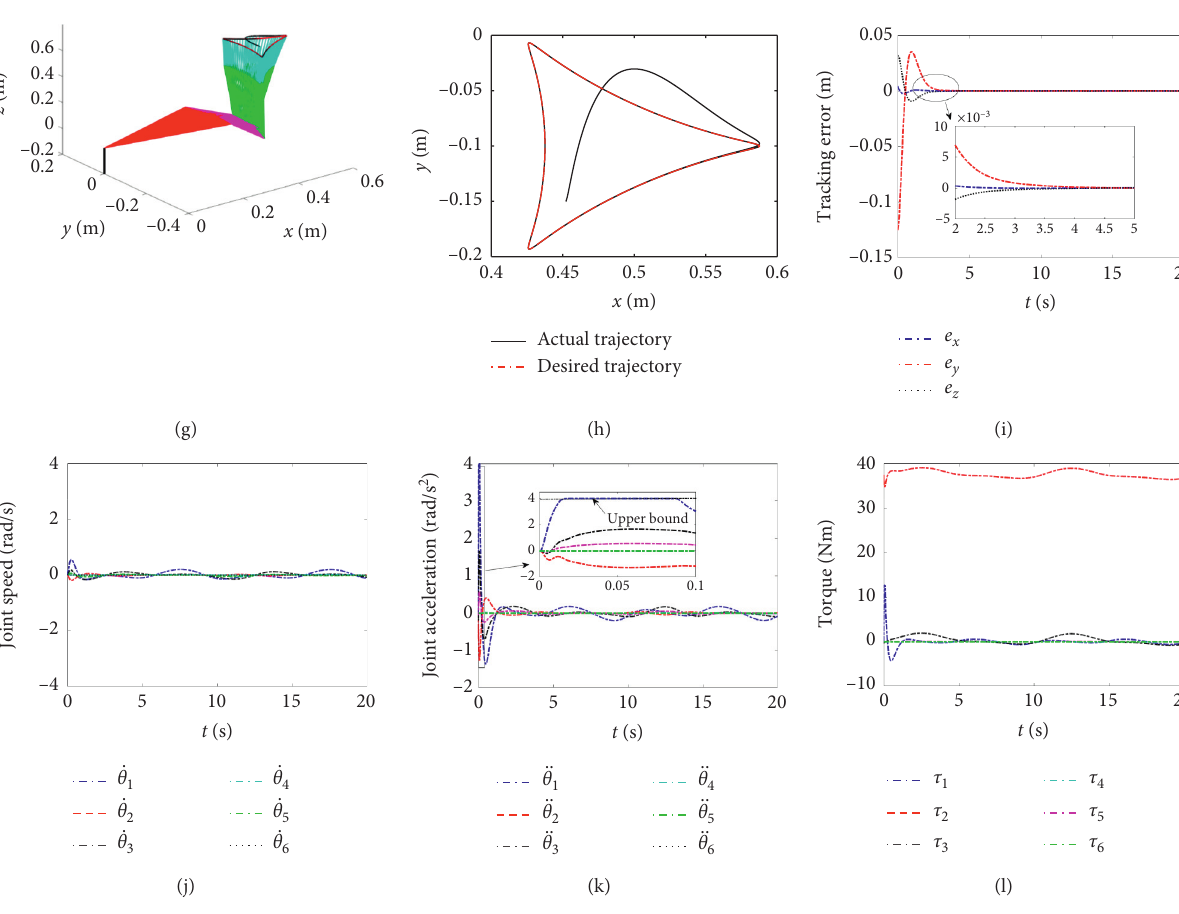
Figure 2: Comparison between the velocity level scheme equation (11) (a–f) and the acceleration scheme equation (10) (g–l) when the manipulator is expected to follow a triangle path. From left to right are 3D tracking results, planer tracking results, tracking error profiles, joint speed profiles, joint acceleration profiles, and joint torque